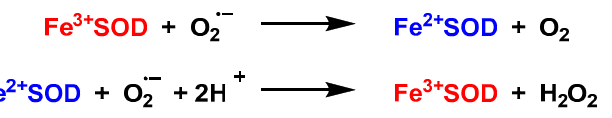
Figure 37. A ping-pong mechanism is displayed in the dismutation of O 2•– by FeSOD.